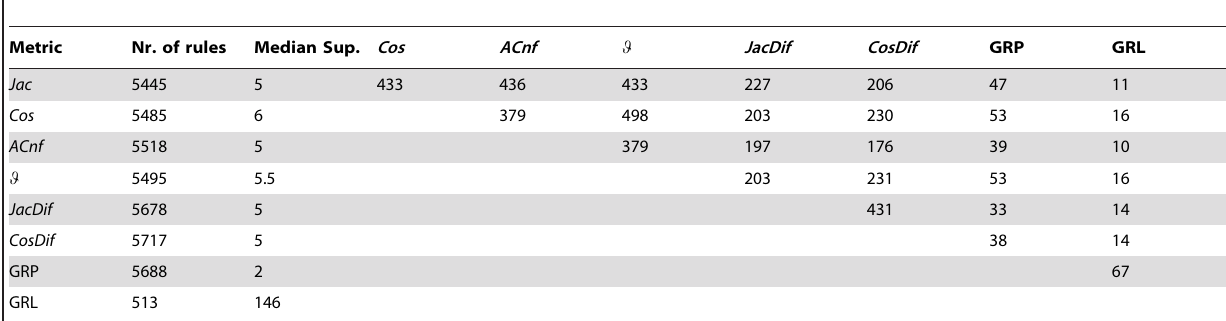
Table 10. Median absolute support and the number of intersections for GO-MF-GO-MF.